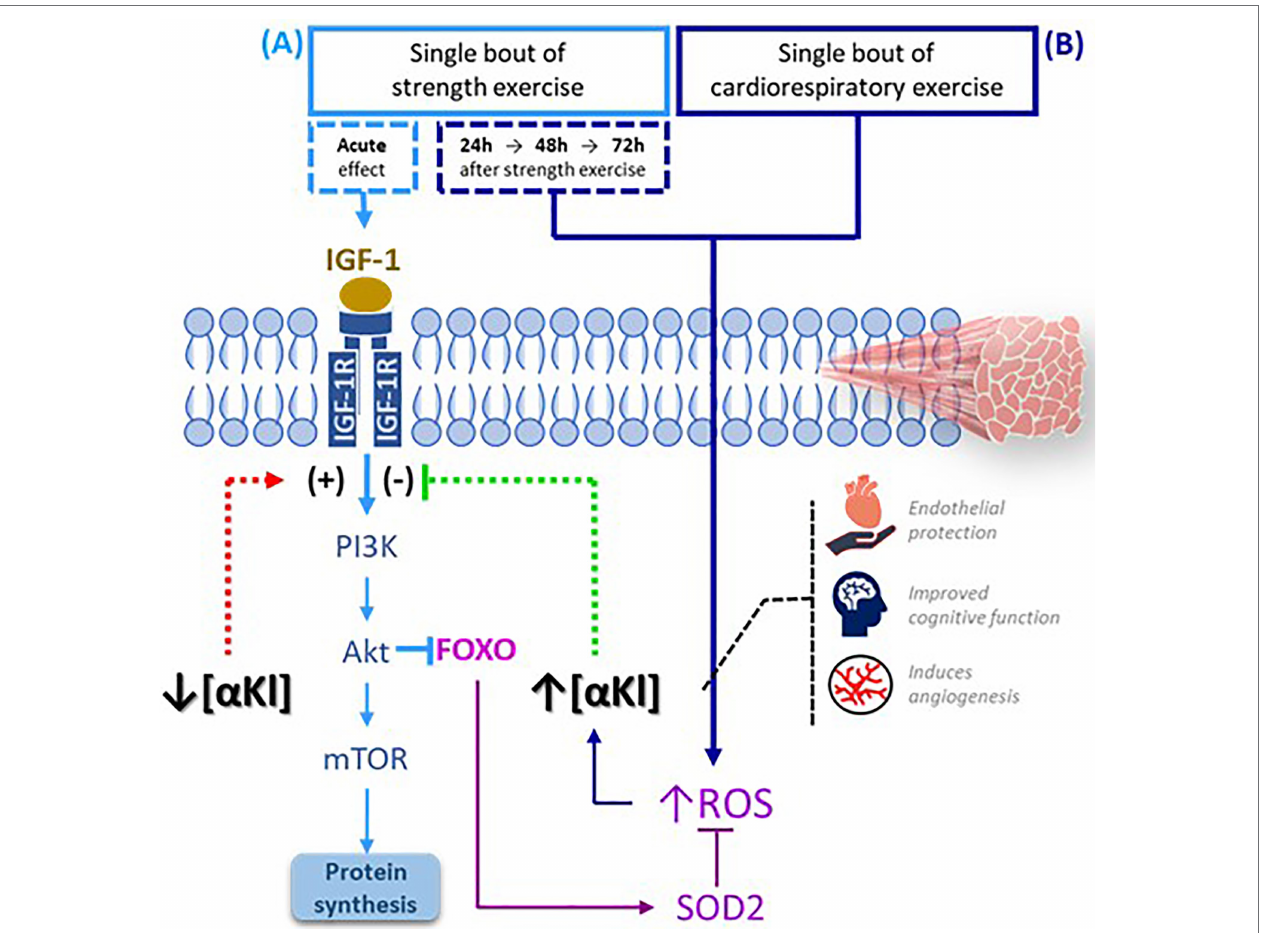
FIGURE 5 | S α KI as a regulator of exercise-activated molecular signaling pathways. (A) Following a bout of strength exercise, plasma S α KI levels fall so that the signaling pathway PI3K-Akt-mTOR is activated through IGF-1 induction with the main objective of protein synthesis. (B) Plasma S α KI levels rise in response to elevated ROS produced by the exercise stimulus just after completing the session in the case of cardiorespiratory exercise and starting 24 h after its completion in the case of strength exercise. ROS levels are regulated through the activation by FOXO of enzymes such as SOD2. FOXO: Forkhead box O; IGF-1: insulin growth factor type 1; IGF-1R: insulin growth factor type 1 receptor; ROS: reactive oxygen species; PI3K: phosphoinositide 3-kinase; Akt: serine/threonine kinase; mTOR: target mechanism of rapamycin